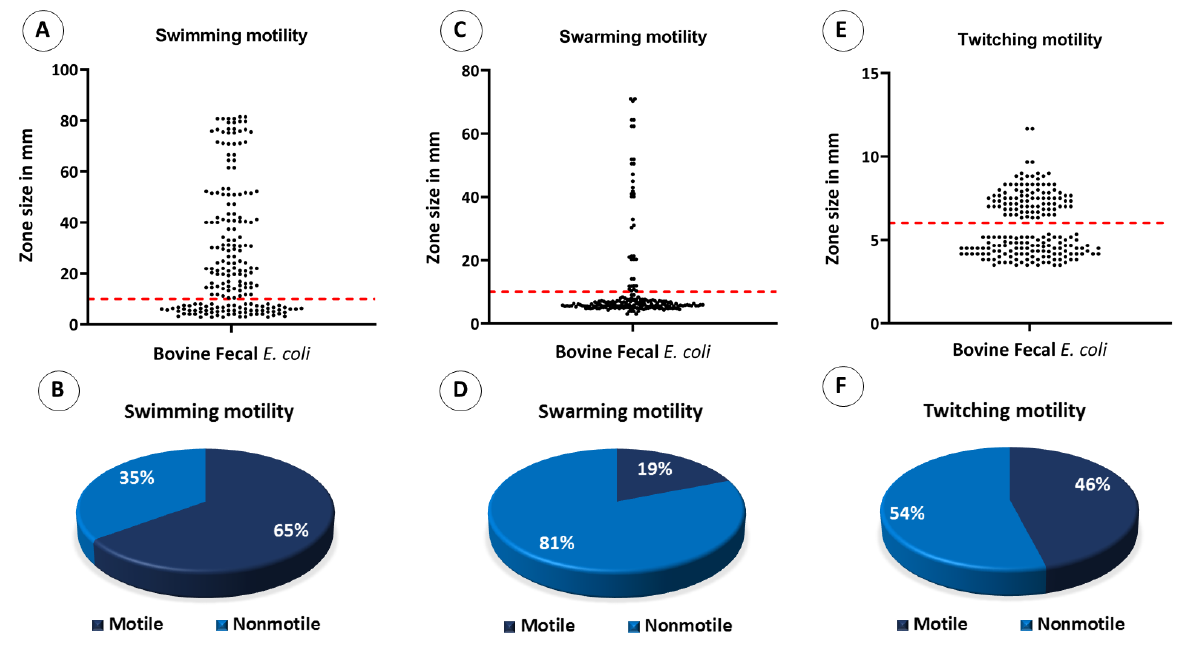
Figure 10. Motility assays by bovine fecal E. coli isolates. Dots in scatter plots represent each isolate’s motility in its respective media, and the red line represents the standard cutoff value required by the strains to be determined motile; the strains at or above the red lines are motile. ( A ) Scatter plot showing swimming motility by bovine fecal E. coli isolates, ( B ) pie chart showing the percentage of isolates that were positive and negative for swimming motility, ( C ) scatter plot showing swarming motility by bovine fecal E. coli isolates, ( D ) pie chart showing the percentage of isolates that were positive and negative for swarming motility, ( E ) scatter plot showing twitching motility bovine fecal E. coli isolates, and ( F ) pie chart showing the percentage of isolates that were positive and negative for twitching motility.